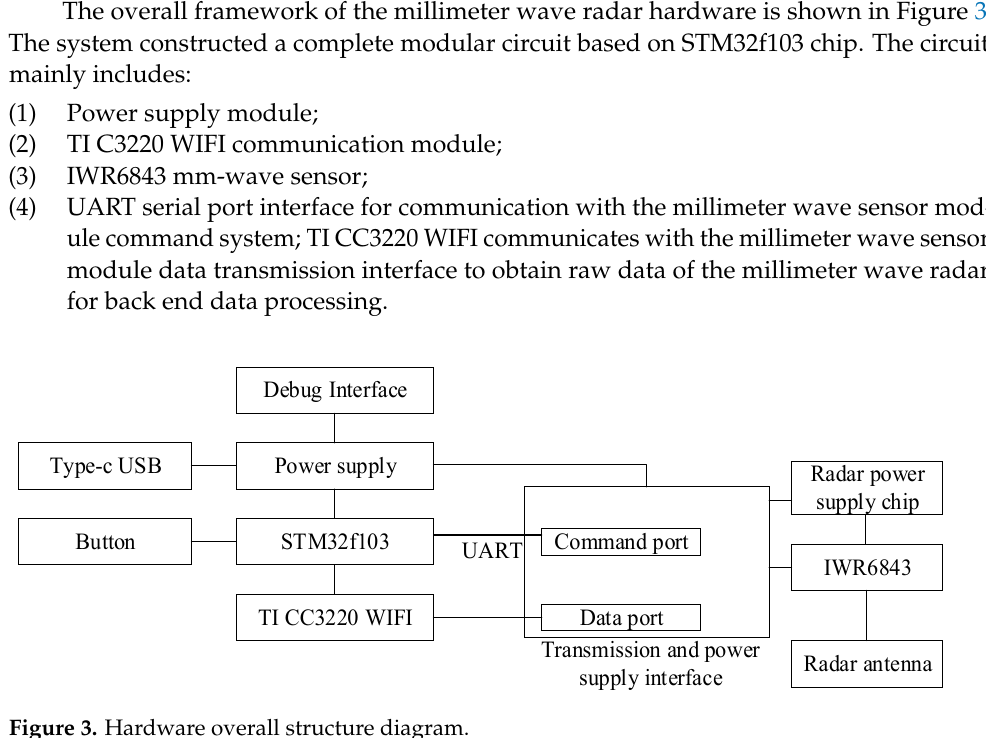
RFIN Figure 6. Block diagram of the receiving pathway principle [5–10,21].